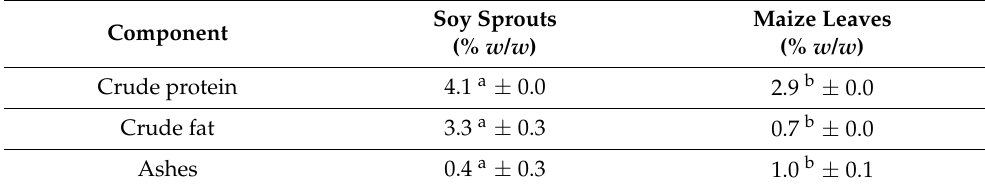
Table 1. Chemical compositions of soy sprouts and maize leaves used to feed grasshoppers.